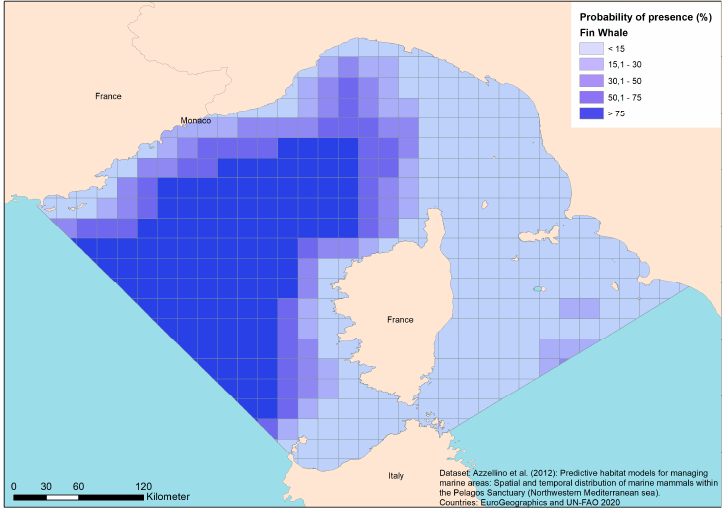
Figure 14. Probability of fin whale presence using data for potentially usable habitat areas as published in [26].